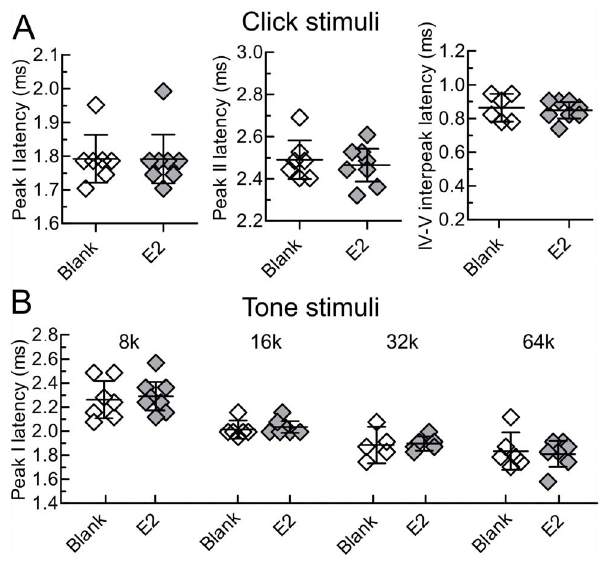
Figure 6. Maternal profile of estradiol does not significantly affect ABR peak latencies. A) Auditory brainstem response (ABR) latencies in response to click stimuli at 20 dB above threshold, at time point ABR3 ( , 3 weeks after implant removal). The specific peaks shown are those that differ between mothers and pup-naı¨ve females in the maternal study. B) ABR latencies in response to tone pip stimuli at 10 dB above threshold, at time point ABR3 ( , 3 weeks after implant removal). Diamonds represent individual animals with the middle bar representing the mean. Error bars represent 95% confidence intervals.